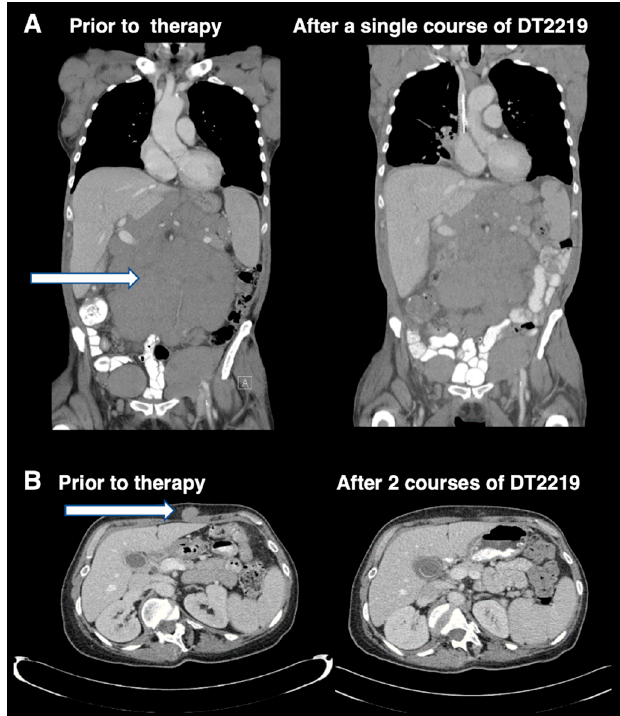
Figure 1. Imaging studies in patients attaining objective phase 1 study responses shown with permission of the AACR and reprinted from reference 10. Figure 1A shows an abdominal CT imaging of a 77 year-old patient with rituximab and chemotherapy-refractory CLL treated with a single course of DT2219 at dose level 40 mg/kg every other day, 4 doses before and at day 28 after therapy. A 40%